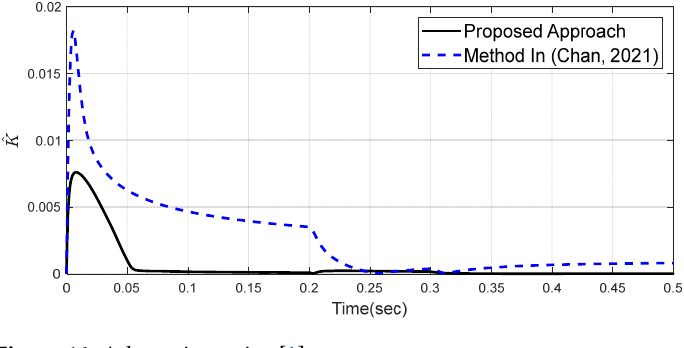
Figure 13. Sliding surfaces [1] .